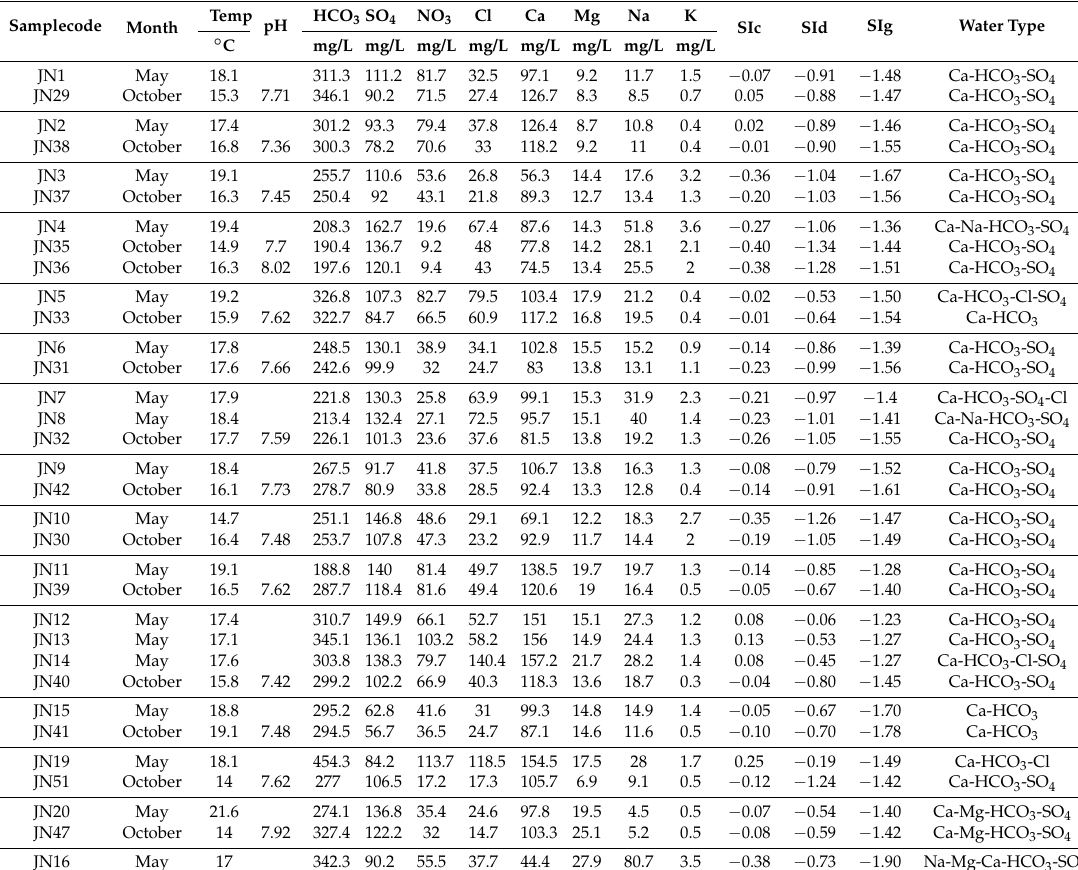
Table 1. List of the field and analytical data as well as the results of some hydrochemical calculations (saturation indexes and water